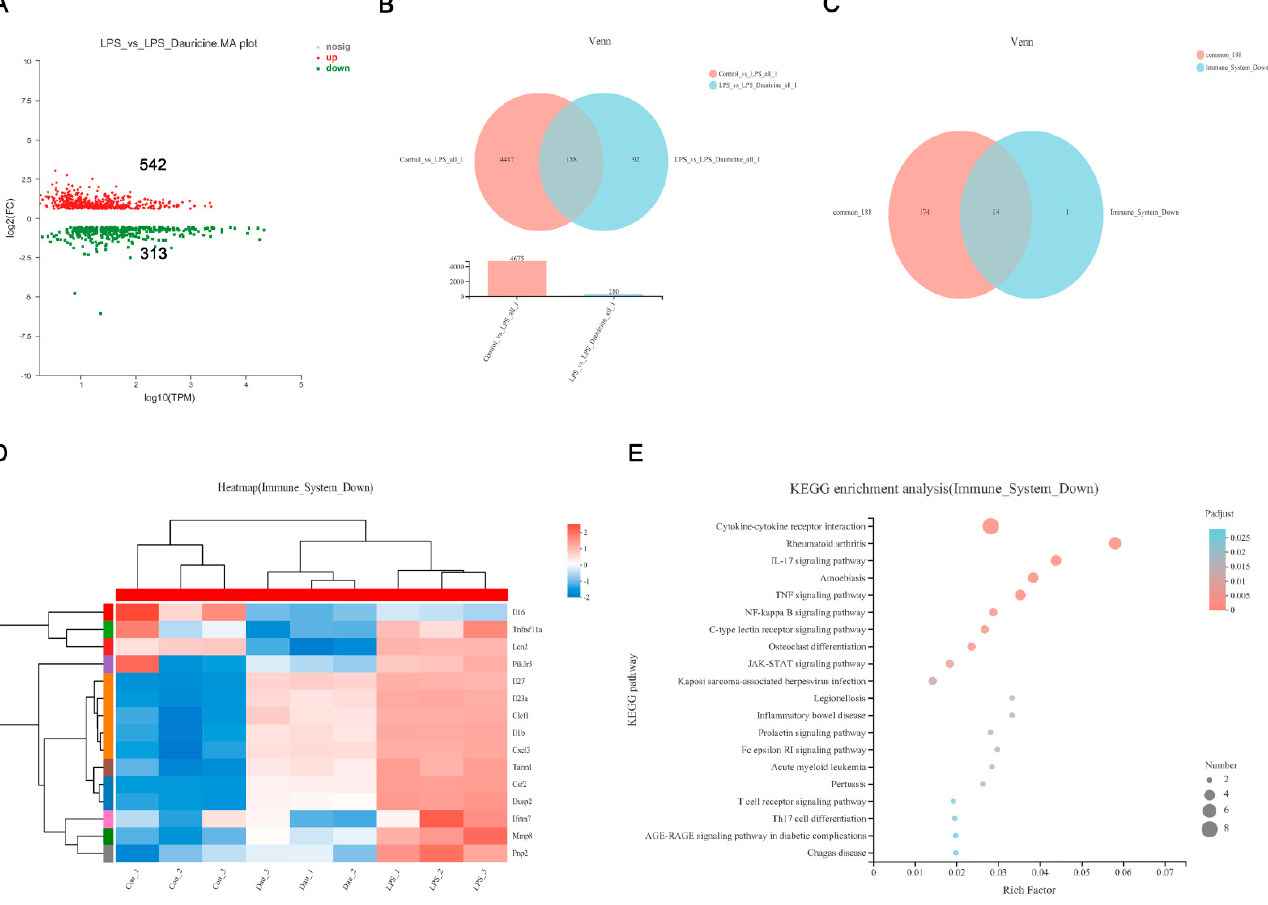
Figure 5. Transcriptomics of LPS or dauricine stimulated primary microglia. ( A ) MA diagram of the expression difference between the LPS and LPS + Dauricine groups. ( B ) Venn analysis of the difference between the Control vs. LPS and LPS vs. LPS + Dauricine sets. ( C ) Venn analysis of the difference between the common 188 genes and immune system downregulated sets. ( D ) Heatmap of the immune system downregulated set and KEGG enrichment analysis of the immune system downregulated set of the 14 gene sets from the common portion of the common 188 genes and immune system downregulated sets ( E ).